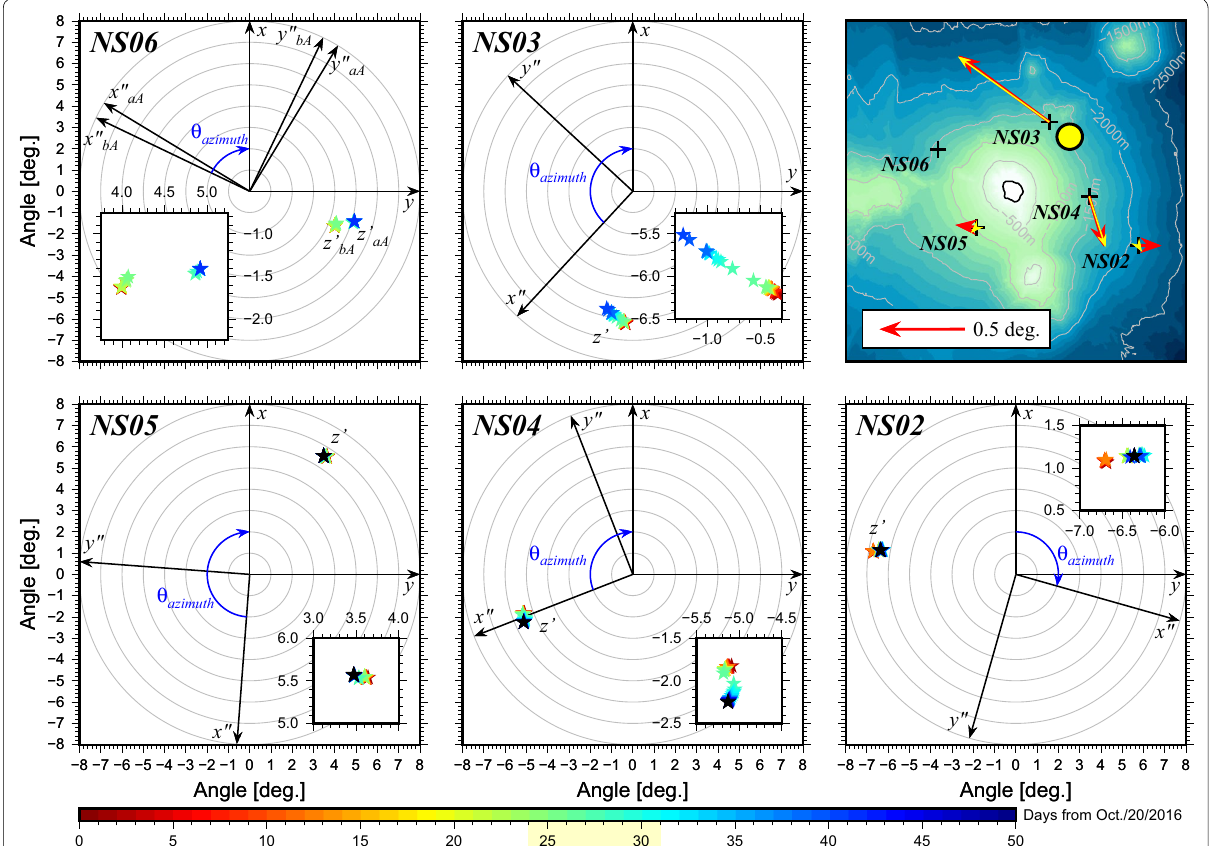
Fig. 3 Tilt variation for each site in the observation period. z ′ axis is projected in the horizontal plane and plotted by stars colored with the days from October 20th, 2016. Days shaded in the color scale correspond to Period A (November 13–19th, 2016). Insets are magnifications of z ′ . The horizontal axes x ″ and y ″ after the tilt correction are plotted by arrows. The angle between x ″ and x is θ azimuth as shown by a blue arc with an arrow. For NS06, x ″ , y ″ , and z ′ are obtained for before and after Period A (denoted with subscripts “bA” and “aA”, respectively). In the top right panel, the tilt variation between November 13th and 19th for each site (except for NS06) is plotted as a red vector on the bathymetry map (Black line indicates the island coast.). Yellow vectors are the tilt variations predicted by a spherical pressure source model and the yellow circle indicates the horizontal location of the pressure (deflation) source with the radius of 1.2